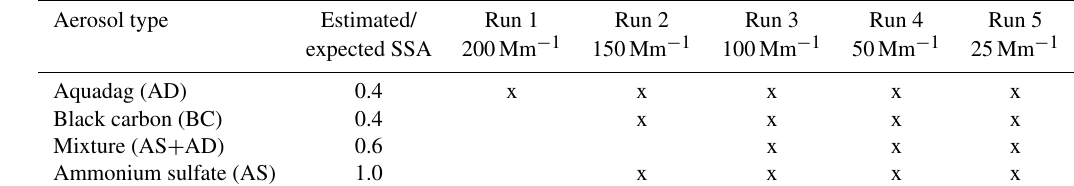
Table 1. Type of generated aerosol, targeted SSA (630nm) and targeted max. aerosol extinction values.